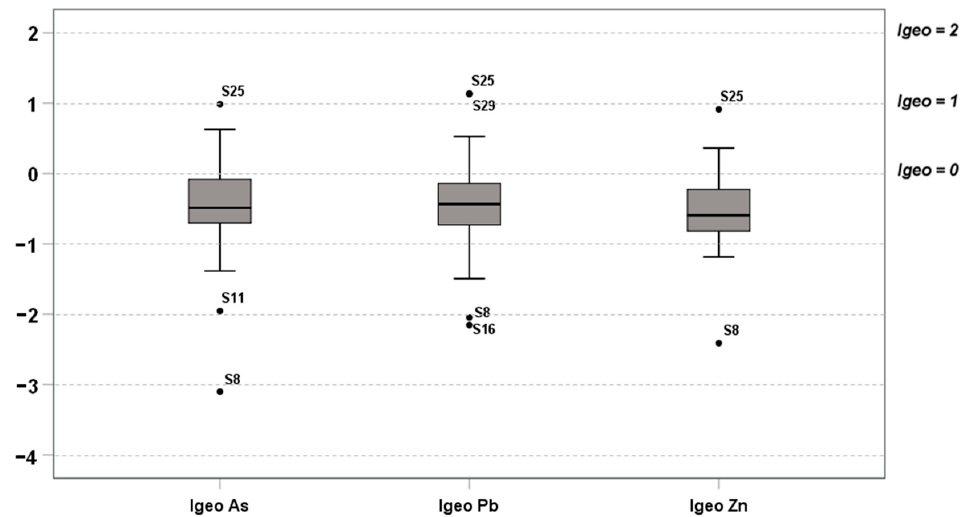
Figure 6. Boxplots for Igeo values of As, Pb, and Zn.